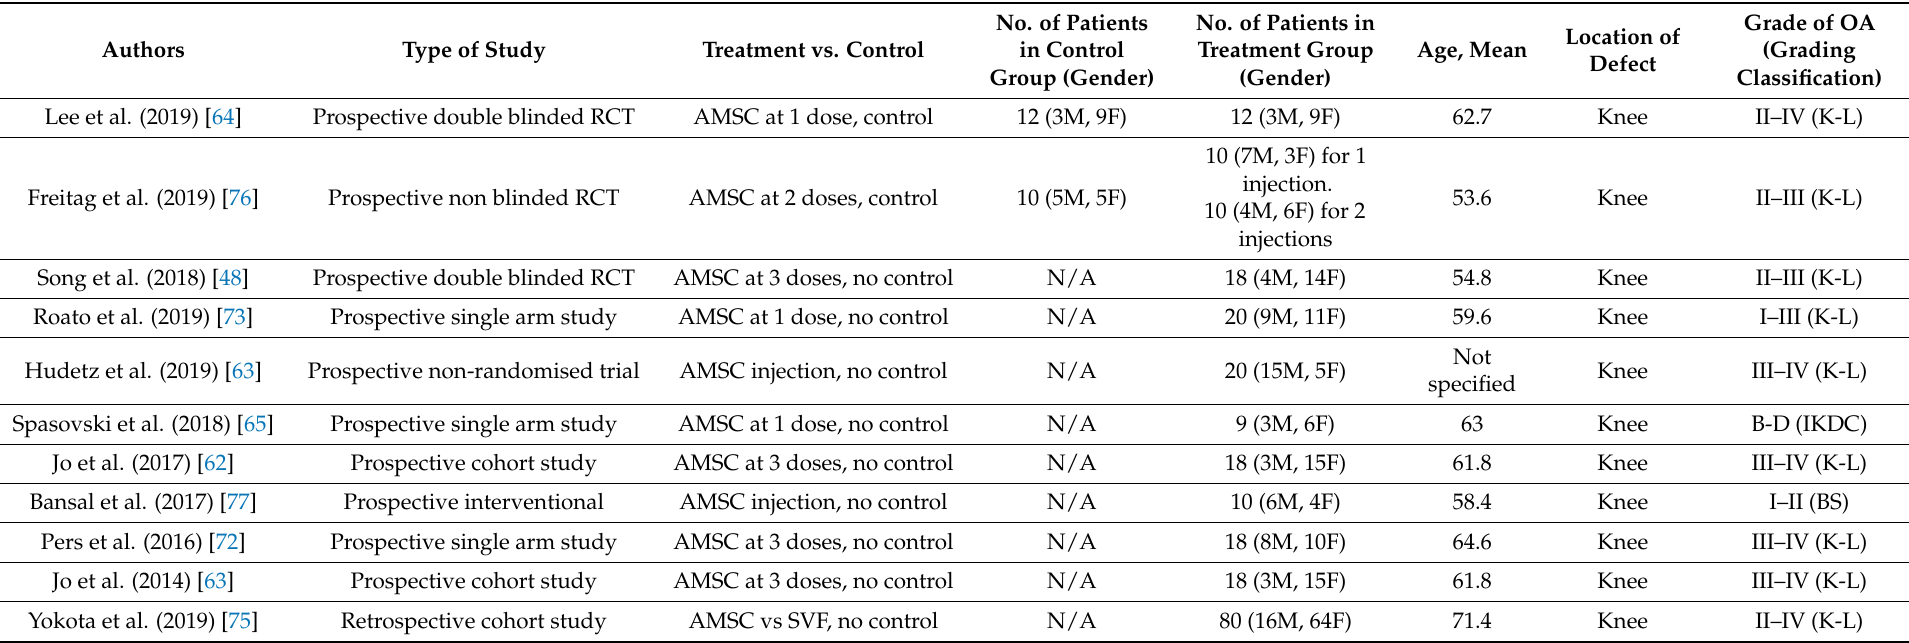
Table 1. Study characteristics for AMSC studies, n = 11.